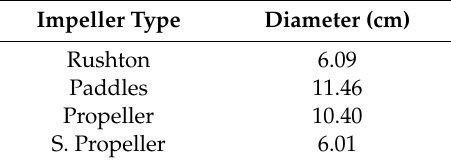
Table 1. Impellers’